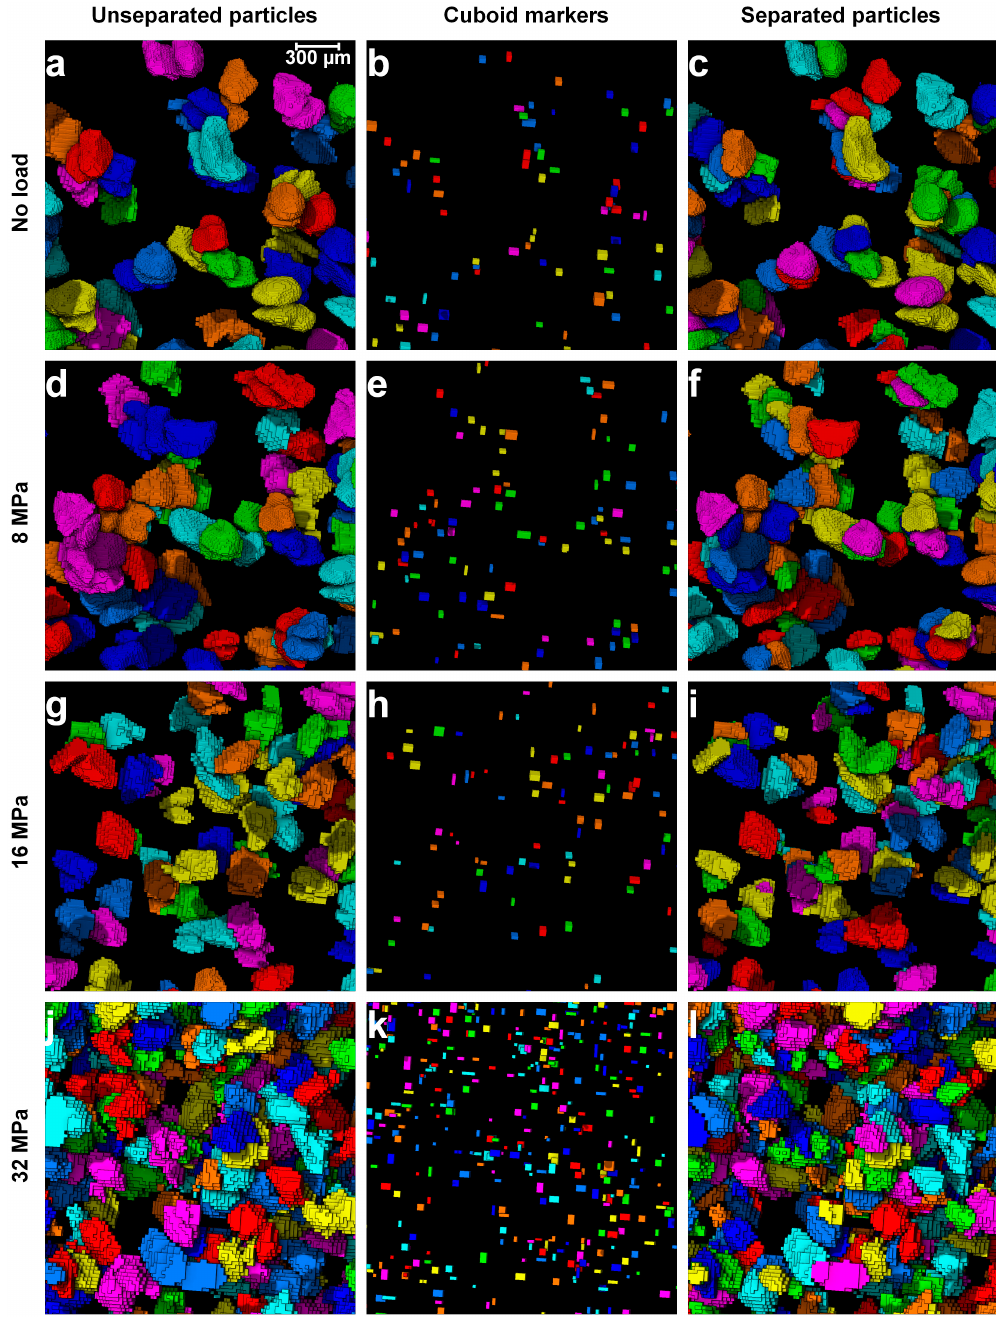
Figure 15. Close-up views of the unseparated particles remaining at the end of the watershed separation with the optimal h -value, cuboid markers and separated particles using the Gaussian mixture models for the sand volume compressed under: ( a – c ) no load; ( d – f ) 8 MPa; ( g – i ) 16 MPa; and ( j – l ) 32 MPa.